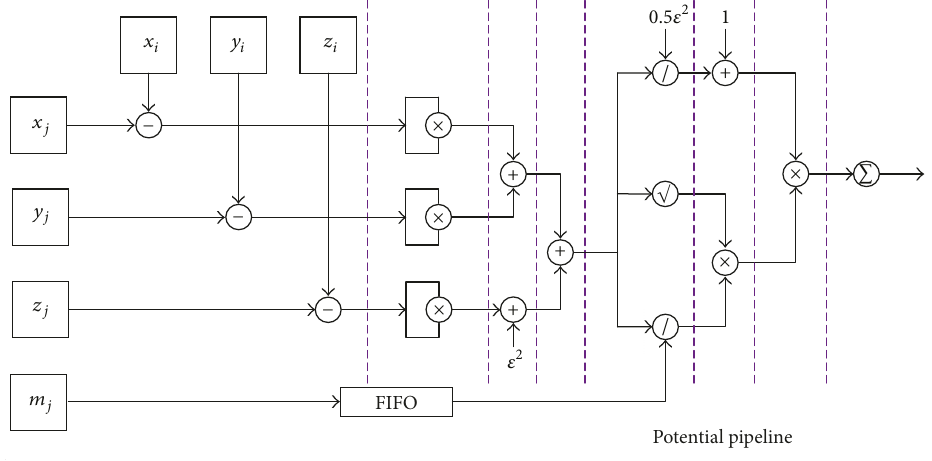
Figure 6: Potential pipeline’s